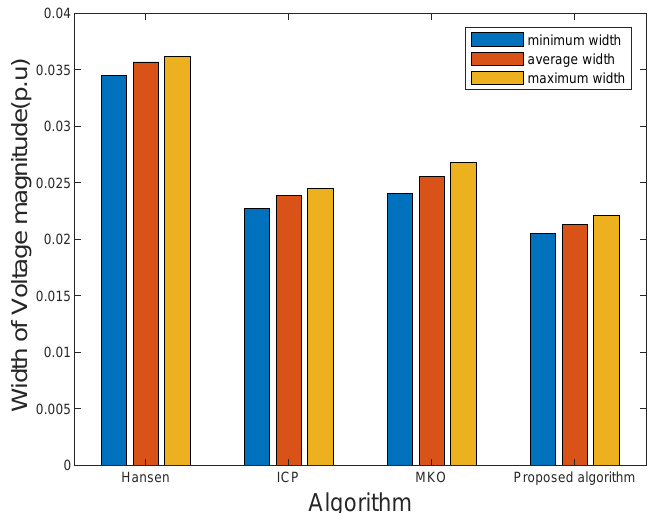
Figure 4. Comparison of bus voltage magnitude values in interval state estimation results on the IEEE 123 bus